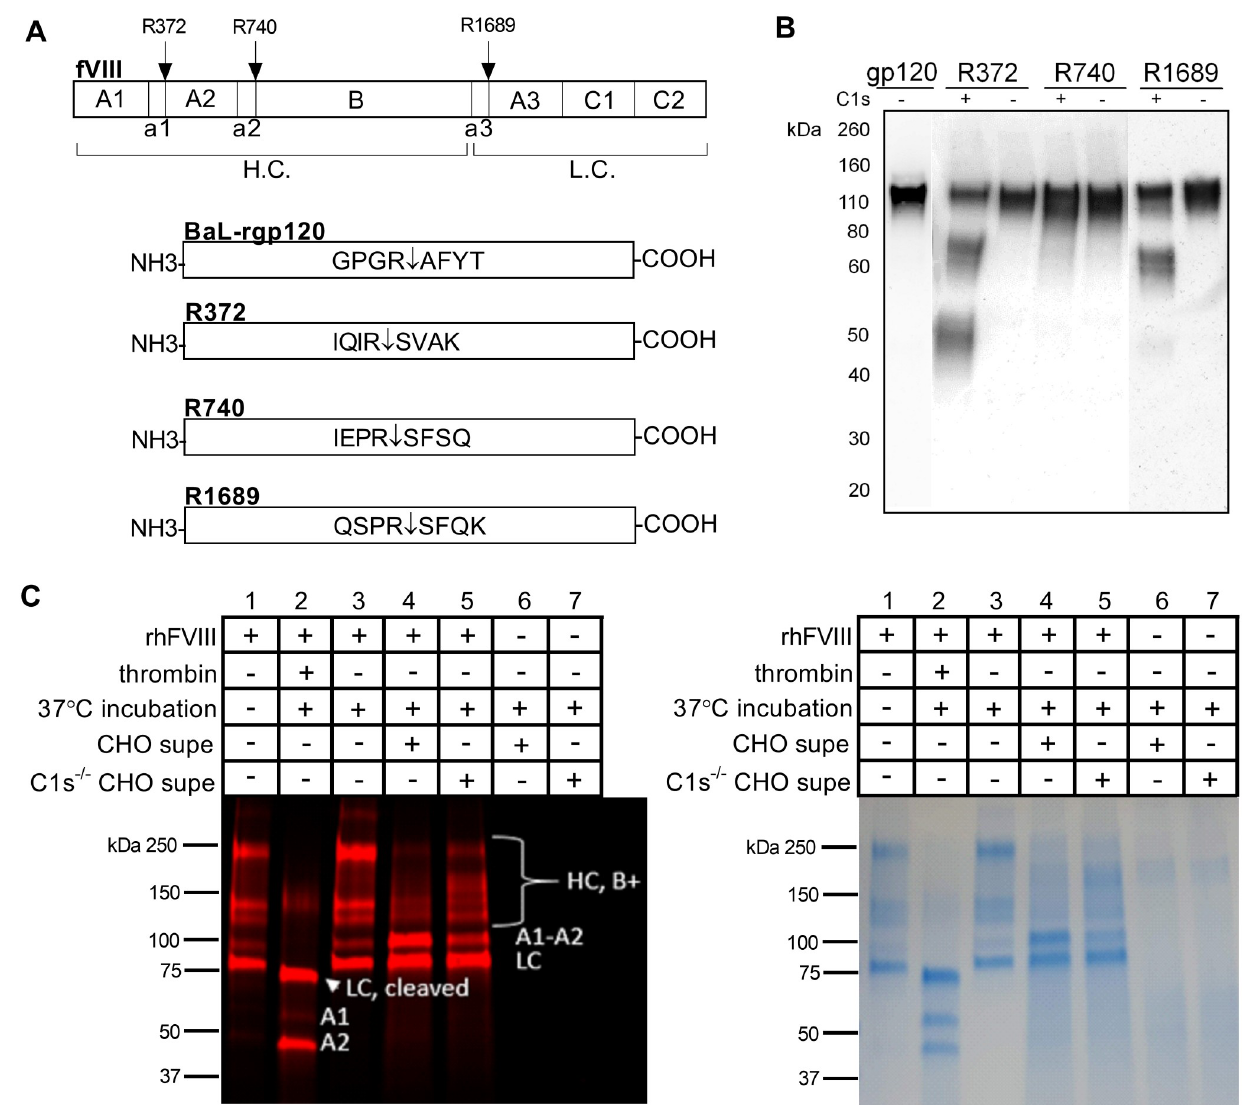
Fig 6. Limited proteolysis of recombinant human Factor VIII by CHO cell-derived C1s. A. The FVIII gene is shown with the three thrombin cleavage sites, R372, R740 and R1689. The heavy chain and light chain are labeled H.C. and L.C. Chimeric gp120-FVIII constructs were created by replacing the C1s cleavage site in the V3 crown of gp120 with thrombin cleavage sites from Factor VIII. The three thrombin cleavage sites on human Factor VIII were cloned into BaL-rgp120 to replace the GPGR # AFYT sequence. Three cloned constructs were created with each of the three thrombin cleavage sites. B. Transient expression and cleavage of the chimeric gp120-Factor VIII constructs R372, R740 and R1689 in either the CHOK1 cell line or the C1s -/- CHOK1 2.E7 cell line. Chimeric constructs expressed in the CHOK1 cell line are indicated with (+) and those expressed in the C1s -/- CHOK1 2.E7 cell line are indicated with (-). Cell culture supernatant was assayed by immunoblot, and samples were all run reduced with DTT. C. Recombinant human Factor VIII (rhFVIII), also known as Advate, was labeled with DyLight650 and tested for proteolysis following treatment with CHO cell and C1s -/- CHOK1 2.E7 cell supernatants. Shown are analyses of FVIII fragments by SDS-PAGE. Thrombin was incubated with rhFVIII as a positive control to observe the expected protein fragments after proteolysis at R372, R740 and R1689. Factor VIII fragments are labeled on the immunoblot as HC (heavy chain), LC (light chain), and the A1 and A2